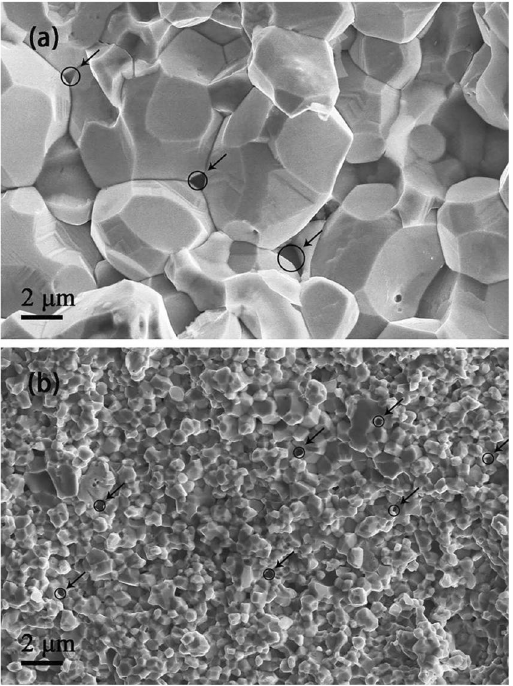
Figure 4. SEM images of the fracture surfaces ( a ) W-Y 2 O 3 alloy fabricated by traditional wet chemical method and subsequent SPS, ( b ) W-Y 2 O 3 alloy fabricated by improved wet chemical method and subsequent SPS.